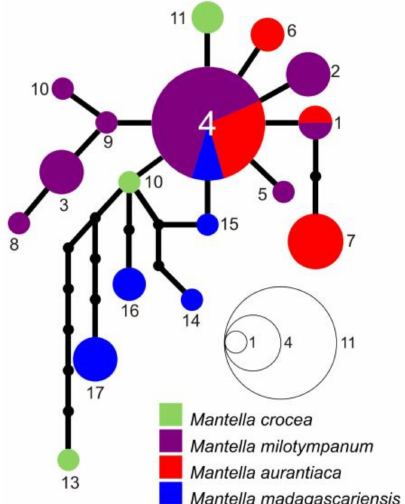
Figure 5. Haplotype network of 17 unique haplotypes of Mantella crocea , M. milotympanum , M. aurantica , M. madagascariensis , and M. pulchra (color code as in Figures 1, 3 and 4), based on the analysis of a 531-bp fragment of the RAG-2 gene. Size of circles is proportional to the number of individuals sharing a given haplotype. Shared haplotypes are indicated by circles, with the area being proportional to the number of individuals sharing that haplotype (haplotype frequencies as in the inset legend). Inferred intermediate haplotypes are indicated by small black